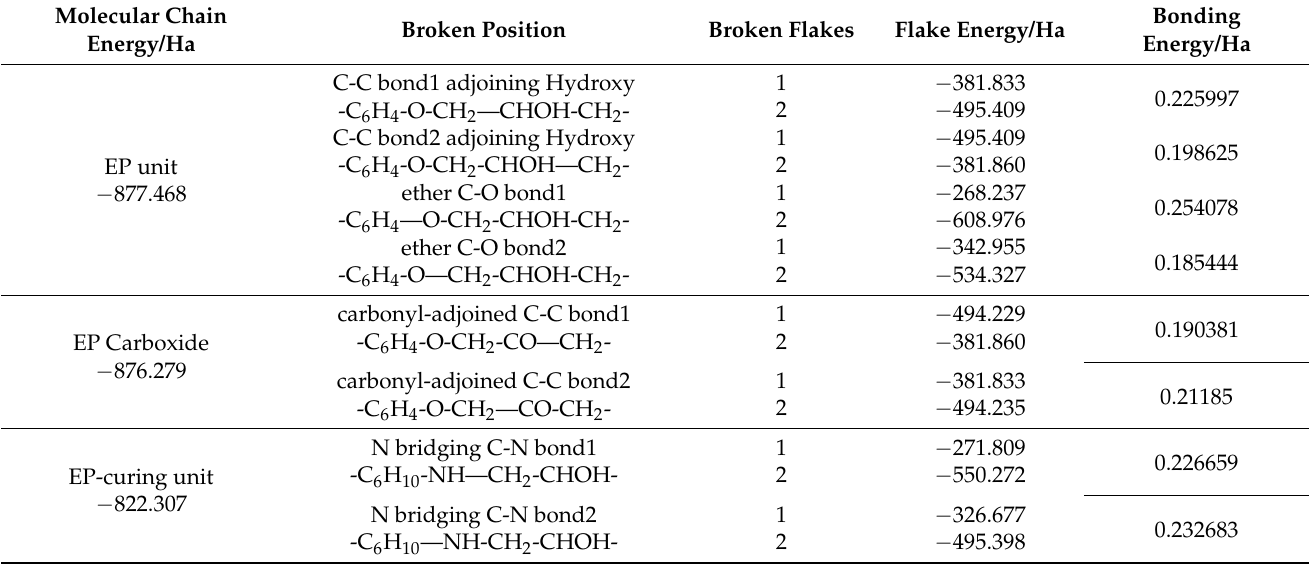
Table 1. First-principles bonding energies of representative C-C, C-O and N-C bonds in the molecular backbone of EP polymer (1 Ha = 27.2